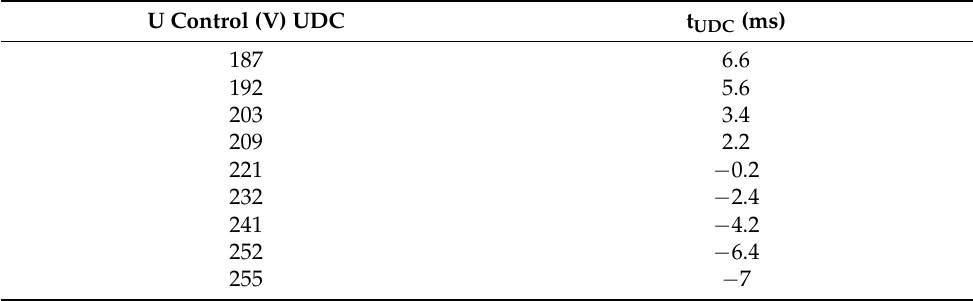
Figure 21 represents the dependency of parameter t UDC on the DC voltage supply on the connection of a circuit breaker.